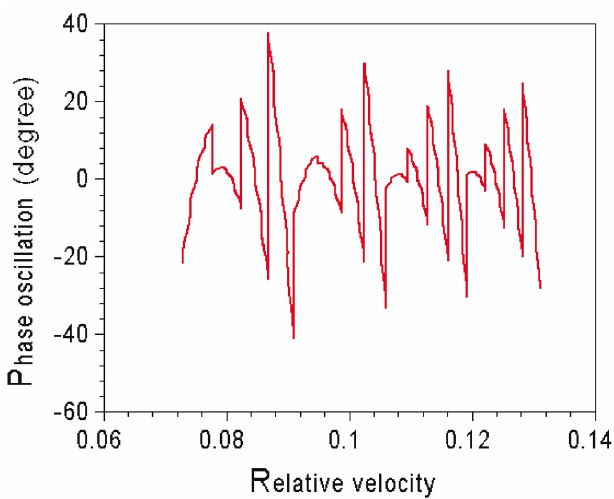
FIG. 16. (Color) Phase oscillation of the quasisynchronous par- ticle vs relative velocity for the first version of the cavity-cavity matching.